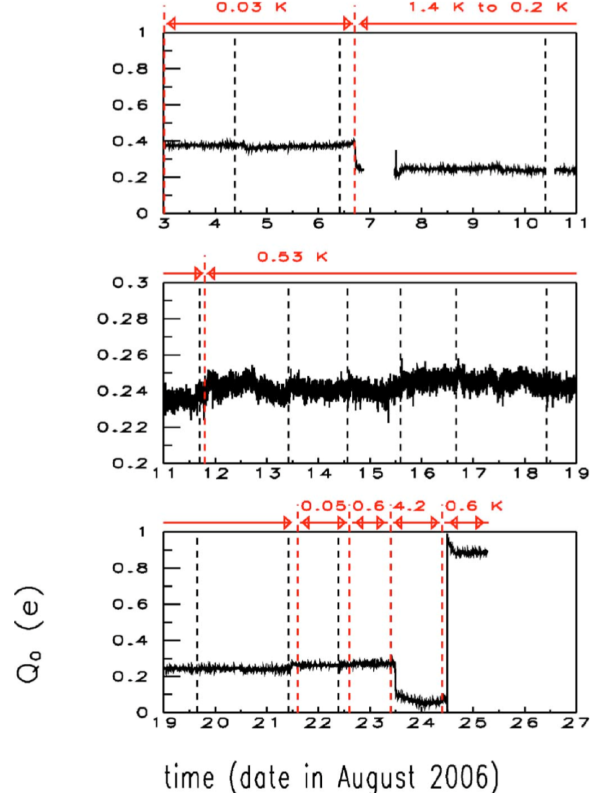
Figure 6. Typical charge offset drift for an all silicon SED with electrostatically generated barriers. A very small amount of drift is observed. Note the vertical axis range in the middle plot. These data were taken while the temperature (indicated at the top of each panel for a range of data indicated by the double arrow) was stepped (each step is indicated by vertical red dashed lines) which shows the insensitivity of the silicon SED to temperature excursions. Black dashed lines represent liquid helium transfers into the cryostat and thus a mechanical disturbance. Reproduced with permission from reference [45], Copyright 2007, American Institute of